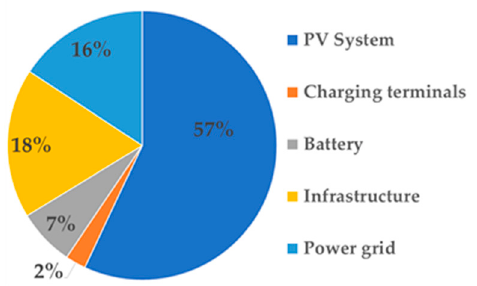
Figure 5. Distribution of the impact carbon of the PVCS.